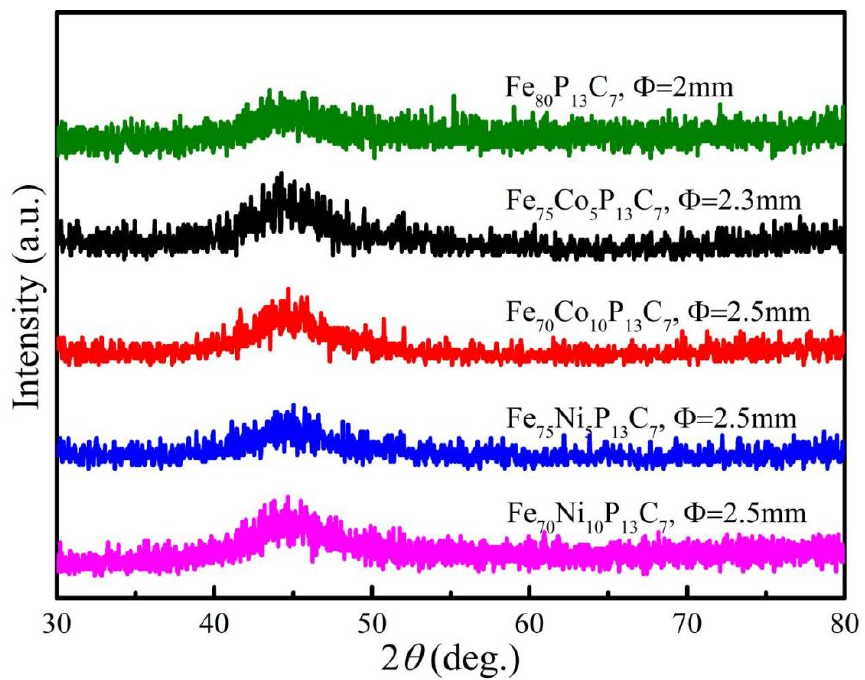
Figure 1. XRD patterns of the as-cast Fe 80-x M x P 13 C 7 (M = Co, Ni; x = 0, 5 and 10 at.%) alloy rods with the corresponding maximum diameter for fully glass formation.